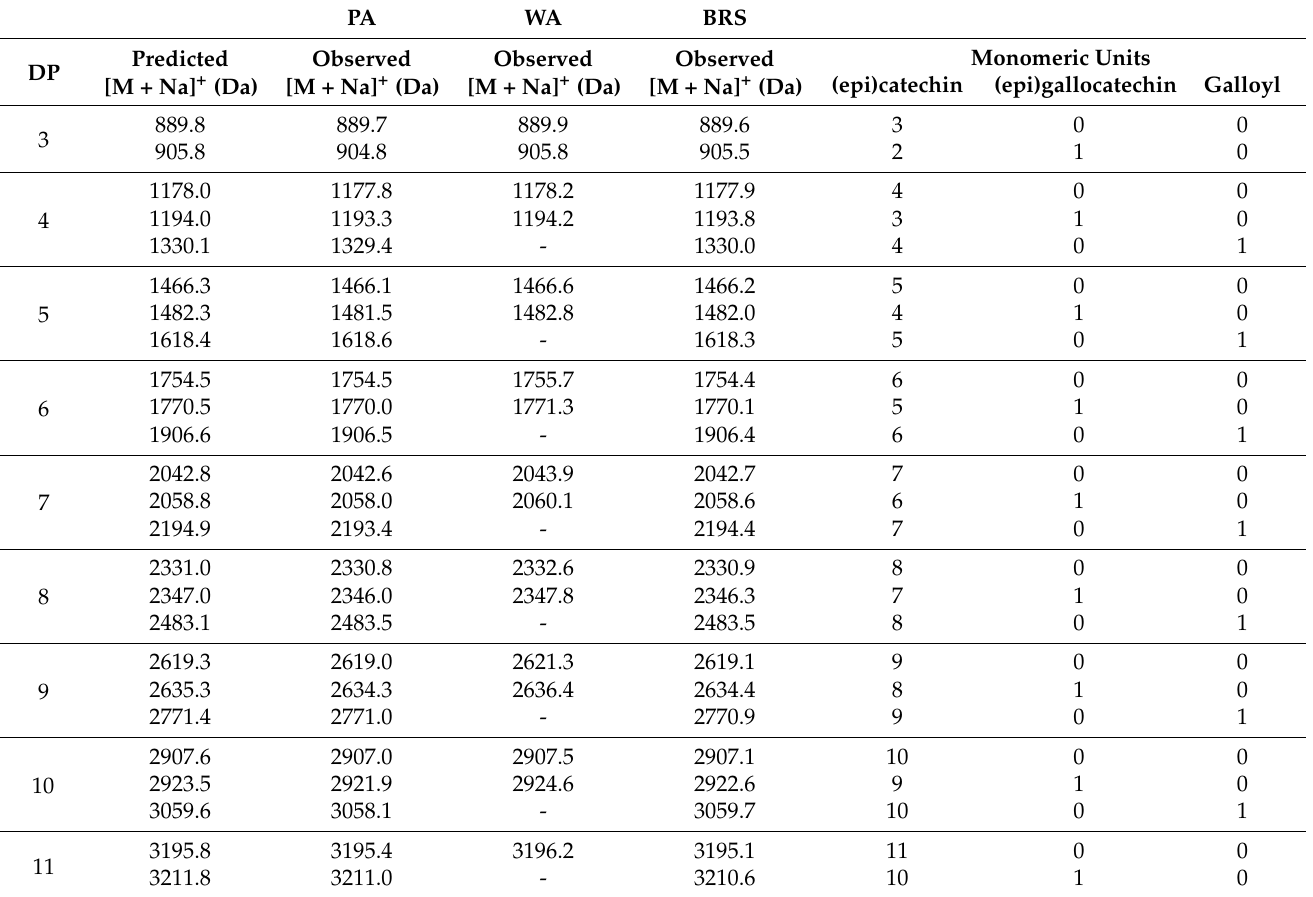
Table 3. PA, WA, and BRS aqueous fractions MALDI-TOF [M+Na] + mass